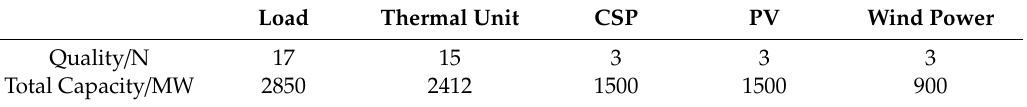
Table 1. Capacity of generators in the modified 24-bus IEEE reliability power system.